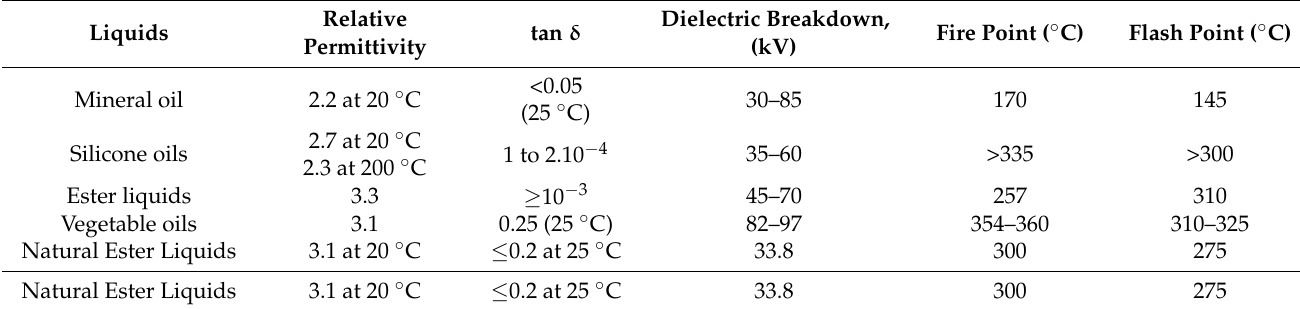
Table 7. Overview of insulating liquids